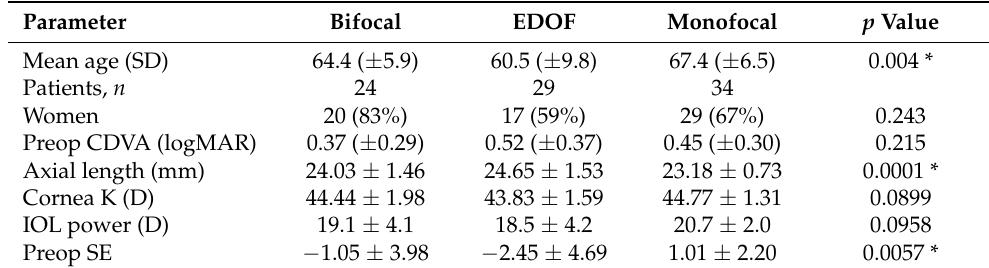
Table 1. Preoperative demographics and visual